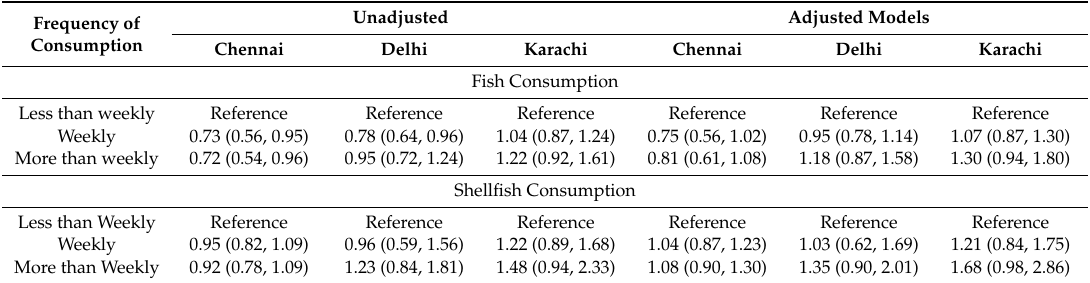
Table 3. Odds ratios (95% confidence intervals) of prevalent diabetes according to fish or shellfish consumption, by city. Note: shellfish consumption is infrequent in Delhi and Karachi. Here, the category “less than weekly” indicates the food item is consumed monthly or never. Adjusted models controlled for age, age 2 , gender, body mass index class, waist–height ratio, sedentary lifestyle, educational attainment, tobacco use, tertile of unhealthy diet score, income, self-reported physician diagnosis of high blood pressure, and self-reported physician diagnosis of high cholesterol. Population parameter estimates are based on a large survey sample including participants from Karachi (unweighted n =